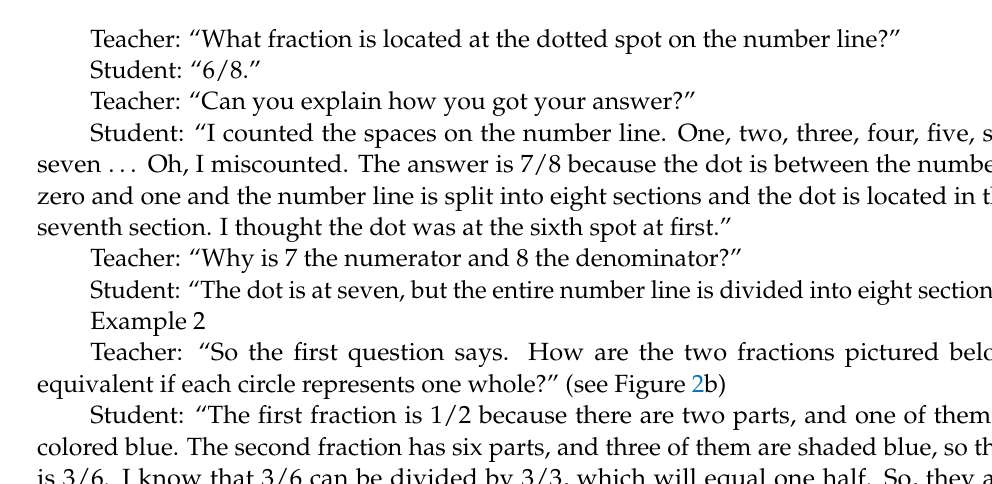
Figure 2. ( a ) Fractions on a number line. ( b ) Using models to represent